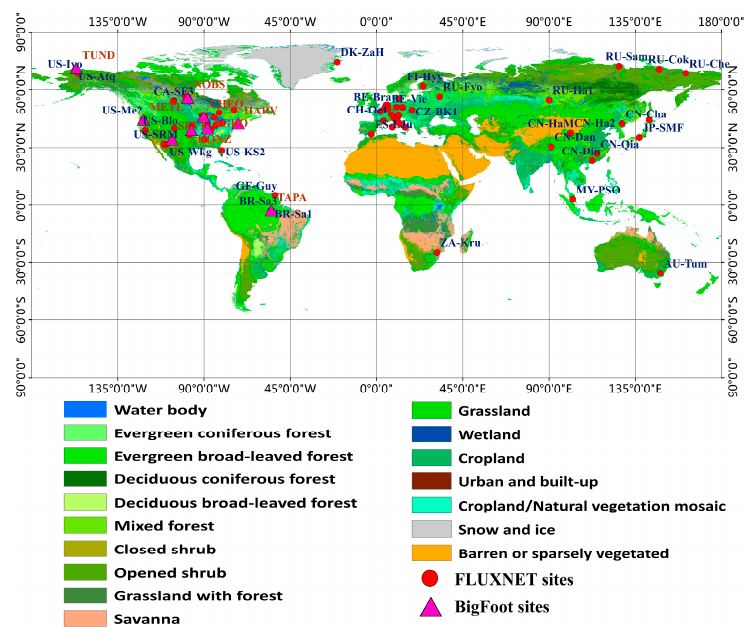
Figure 2. MODerate Resolution Imaging Spectroradiometer (MODIS) International Geosphere Biosphere Program (IGBP) land-cover and location of FLUXNET sites and BigFoot sites.